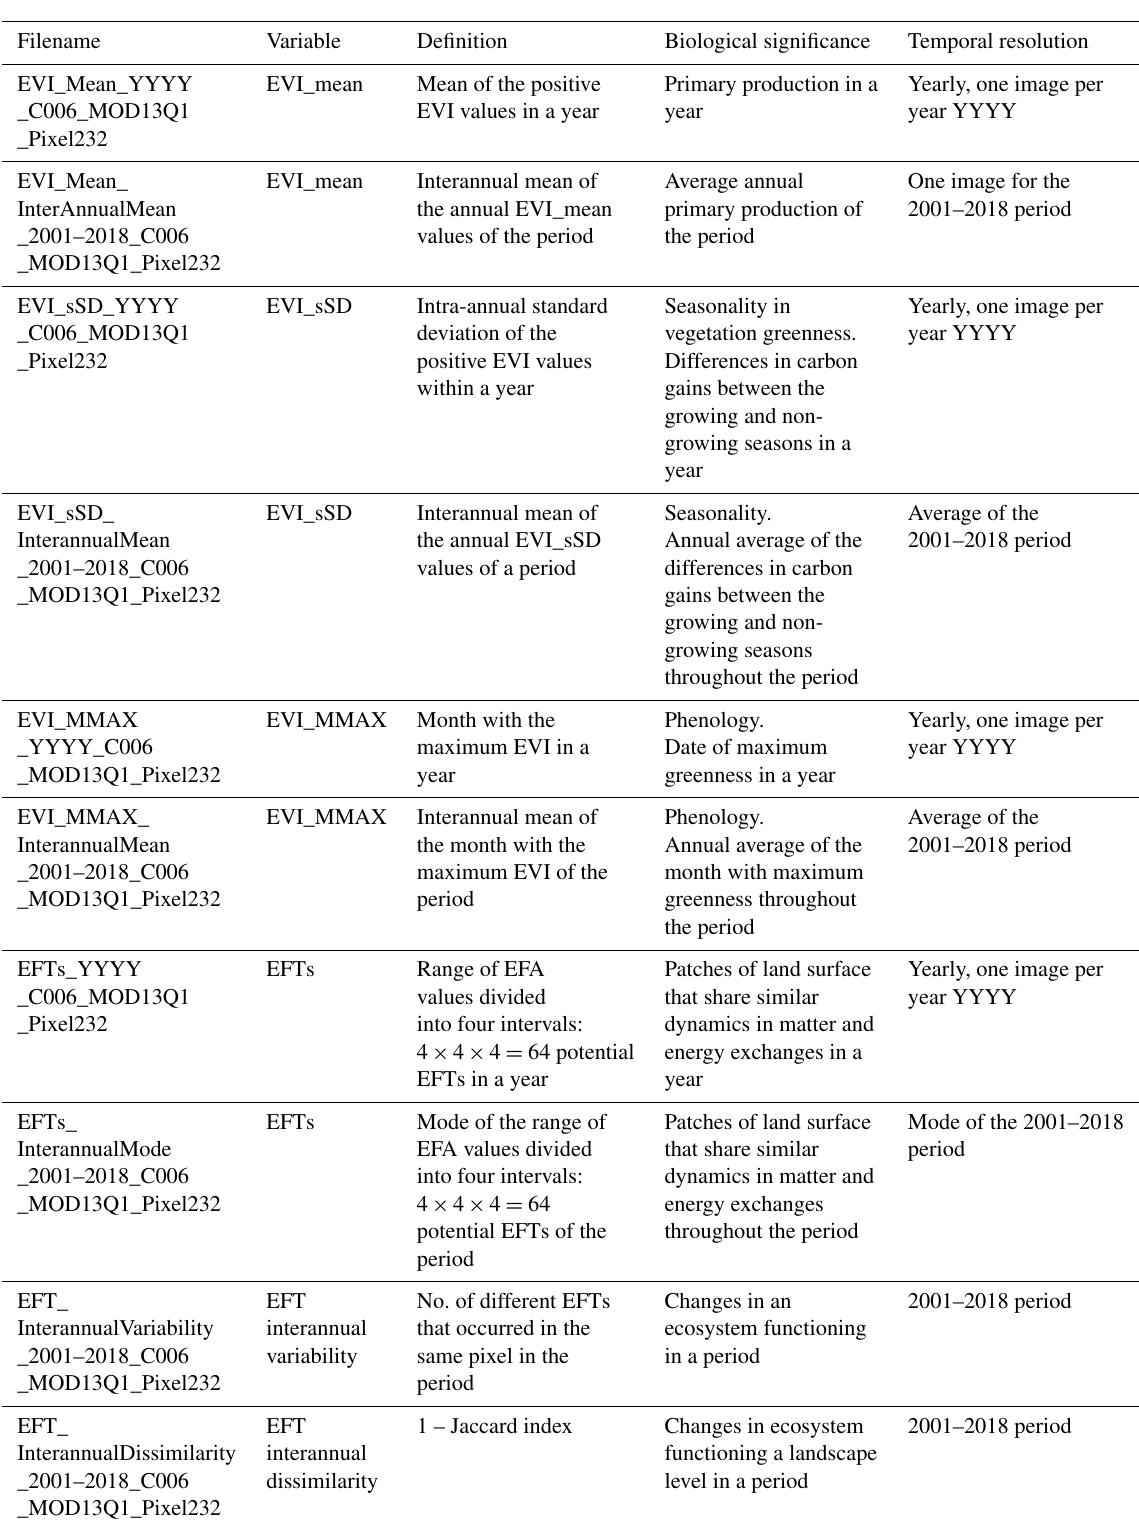
Table 2. Dataset description: EFAs (EVI_Mean, EVI_sSD, and EVI_MMAX provided yearly and summarized for the 2001–2018 period as an interannual mean); EFTs provided yearly and summarized for the period as interannual mode, variability, and dissimilarity; ecosystem functional diversity (EFT richness and EFT rarity, provided yearly and summarized for the period as an interannual mean). The spatial resolution is ∼ 231 in all cases except in the EFT dissimilarity, where it is ∼ 232m × 4 =∼ 1km 2 . YYYY refers to the year and varies from 2001 to